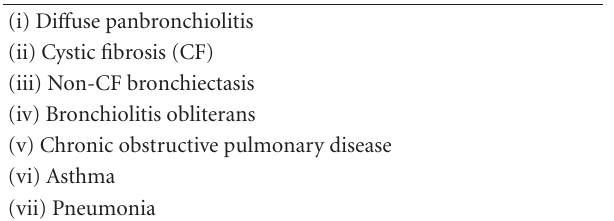
Table 4: Conditions for which macrolide use may be beneficial, pri- marily as a result of their anti-inflammatory, immunomodulatory